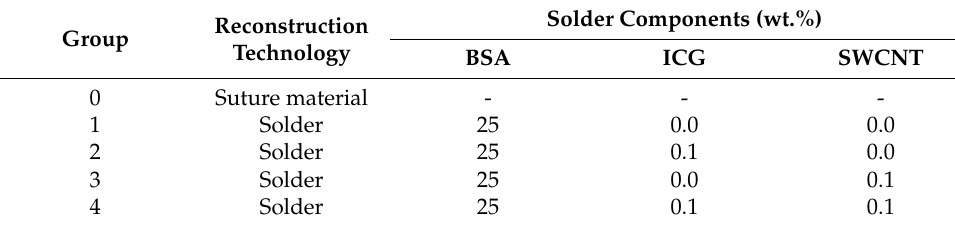
Solder Components (wt.%)